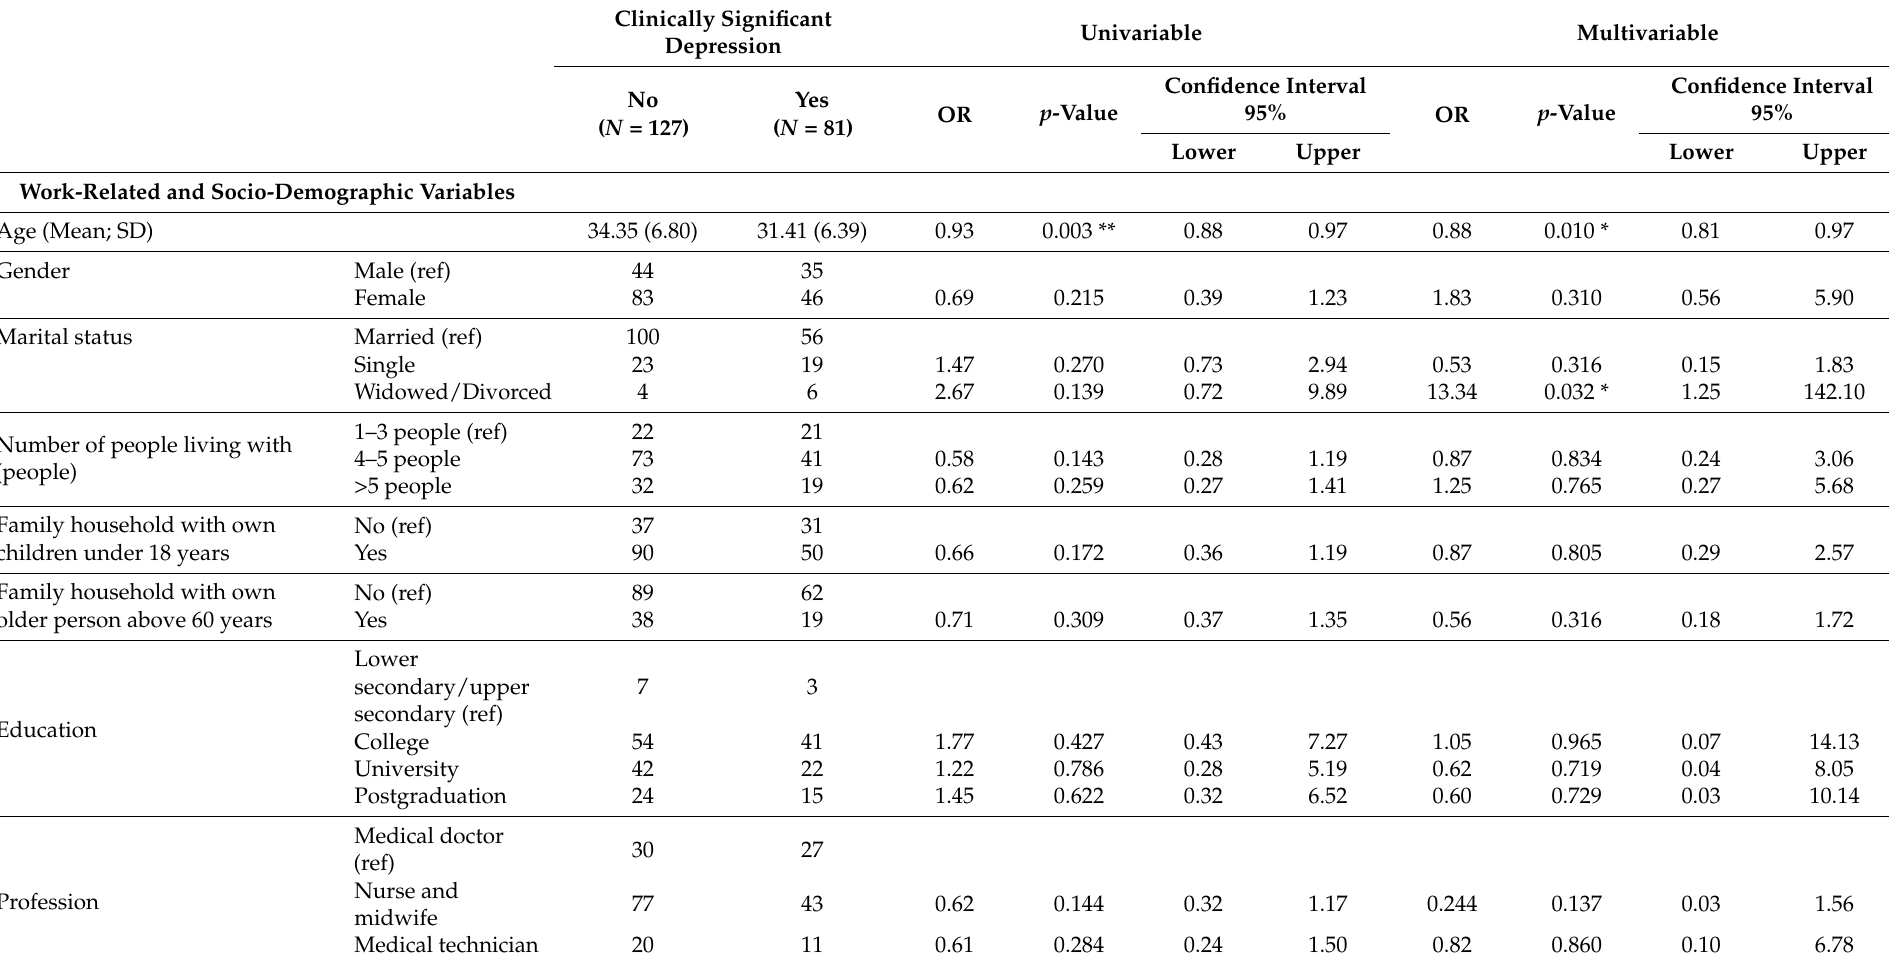
Table 4. Analysis of factors associated with the symptoms of depression: univariable and multivariable logistic regression. Clinically Significant Univariable Depression